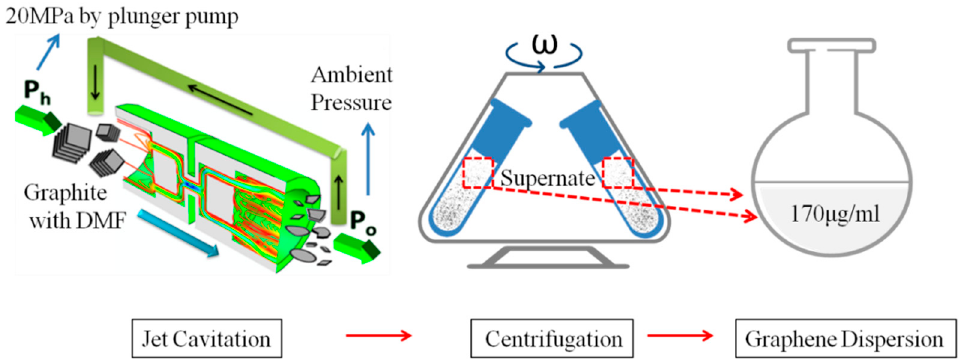
Figure 1. The process of graphene dispersion preparation [45].